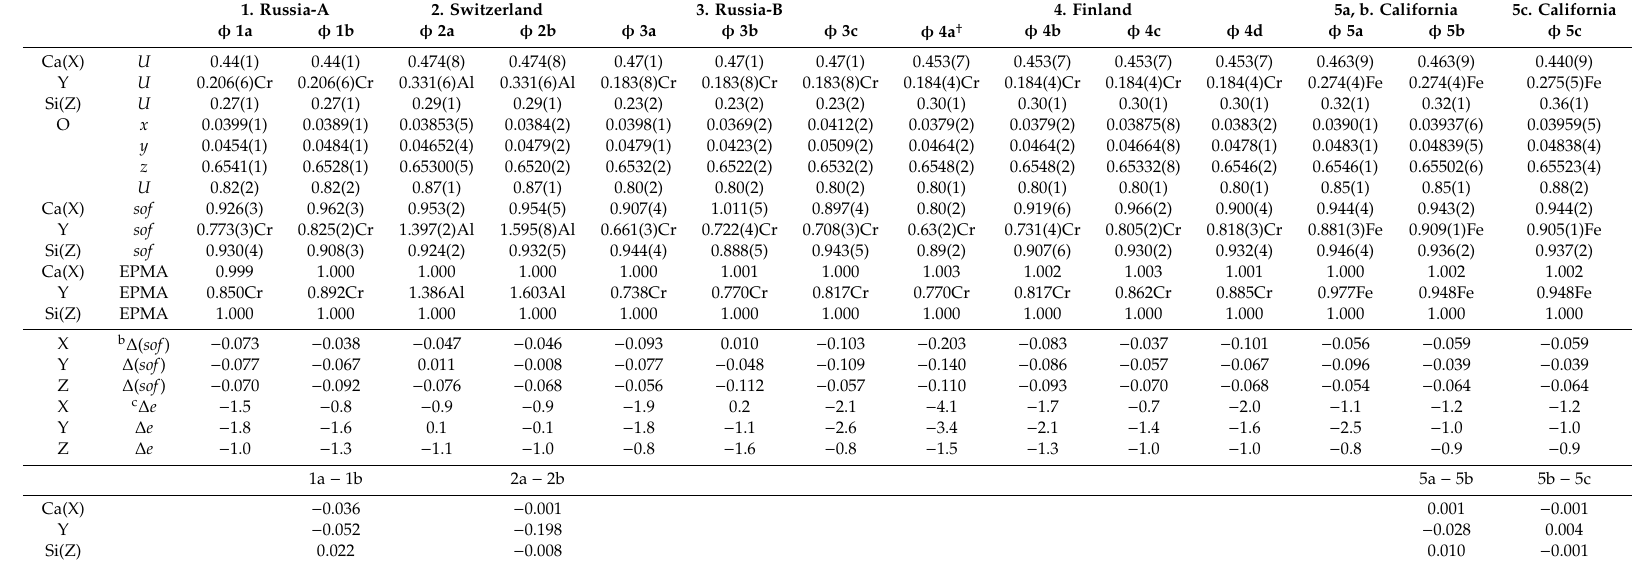
Table 4. Atom coordinates a , isotropic displacement parameters, U × 100 (Å 2 ), and sofs for five uvarovite samples (including Grs and